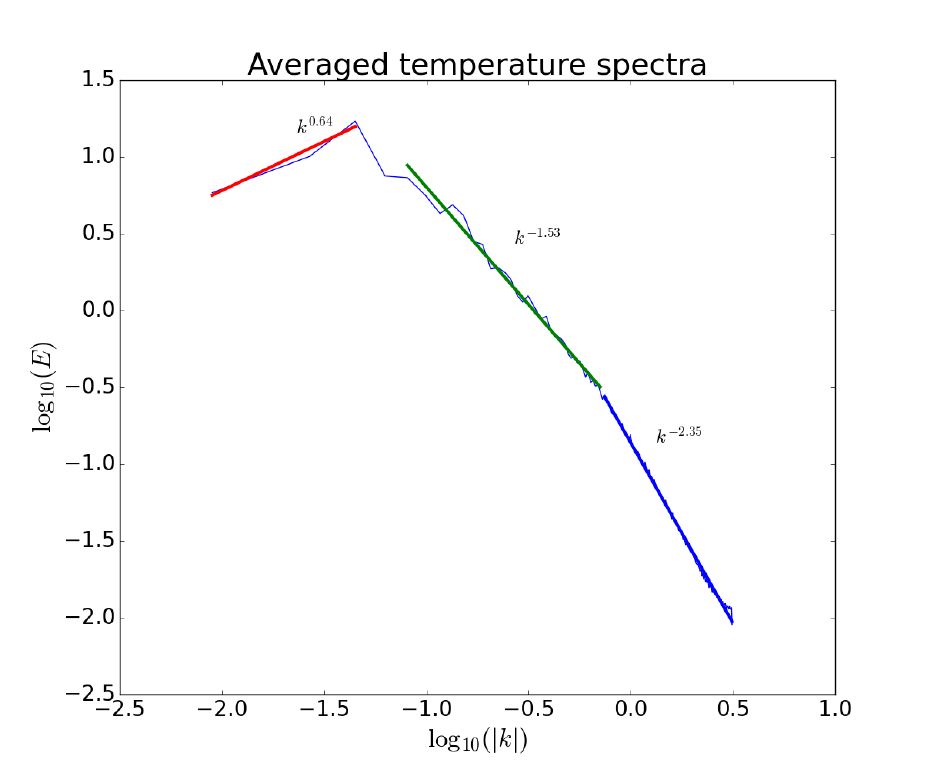
Figure 3. Integrated spectrum of the spatial component of the dynamics of Faraji, averaged over each acquisition time instant. The exponents represent the spectral indices of the wave number obtained from the linear fit in the three zones of the spectrum corresponding to macro-, meso-, and small-scales. The spectrum shows the energetic content log | E | (with | E | representing | T | 2 ) as a function of log | k | , with k normalized to the total size of the image (namely multiplied by k 0 = 2 π (cid:96) the image along both the longitude and latitude